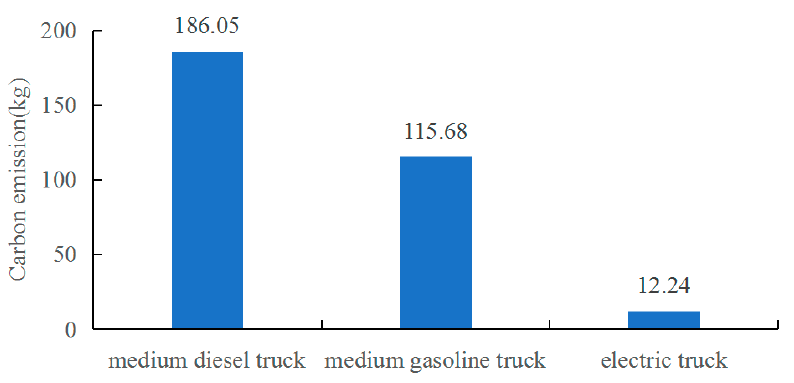
Figure 9. Carbon emissions from CG-2 composite beams transported by different energy vehicles.